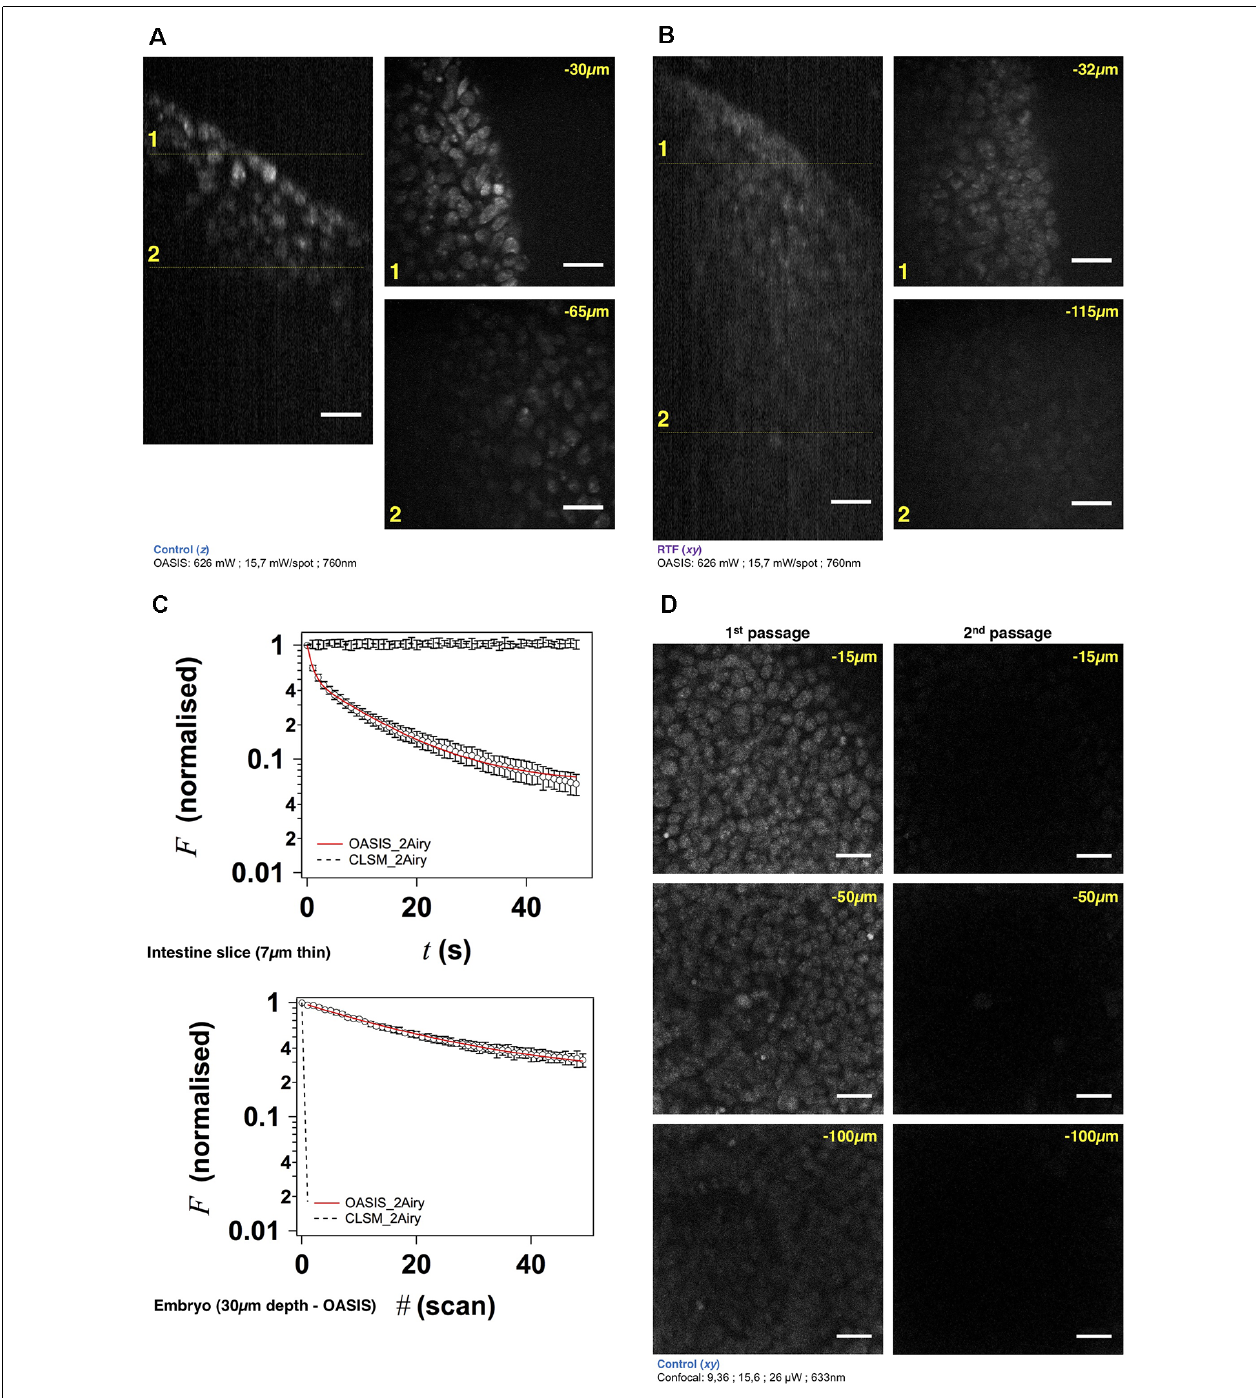
FIGURE 3 | The OASIS microscope outperforms a CLSM point-scanner for 3-D embryo imaging. (A) 3-D data set taken with the OASIS in a non-cleared embryo stained with TO-PRO3 (Control). Panels show xz- projection of a z -stack of images ( right ) and xy -planes ( left ) corresponding to the dashed lines at 30 µ m (1) and 65 µ m imaging depth (2), respectively. Scale-bar, 25 µ m. (B) same, at 32 µ m (1) and 115 µ m depth (2), respectively, for an RTF-cleared embryo. Scale-bar, 25 µ m, as in (A) . (C) Representative bleaching curves during continuous acquisitions, from a single z -section in—respectively—a thin slice of intestine ( top ) and of TO-PRO3-labeled nuclei ( bottom ) at 30- µ m imaging depth in an embryo. (D) Representative planes at various imaging depths (15, 50 and 100 µ m, respectively) of a 3-D data set (200 planes from the surface to 200 µ m, ∆ z = 1 µ m) acquired from a TO-PRO3-labled embryo. The two columns show the sections during the 1st passage ( left ) and during the 2nd passage, after completion of the 1st image stack ( right ). Note the almost complete bleaching prohibiting repetitive volume imaging for the CSLM but not the OASIS microscope. Measured laser powers are given for each depth. Scale-bar, 25 µ m.